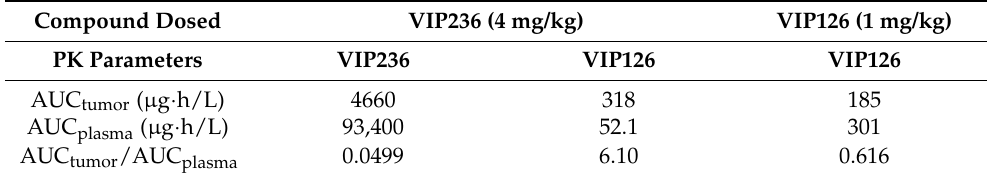
Table 5. Plasma and tumor pharmacokinetics of VIP236 and VIP126 in female NMRI nu/nu 786-O tumor-bearing mice following administration of a single i.v. dose of VIP236 at 4 mg/kg or VIP126 at 1 mg/kg. The doses of VIP236 and VIP126 deliver equimolar amounts of VIP126. Pharmacokinetic parameters were estimated from mouse concentration–time profiles ( n = 2